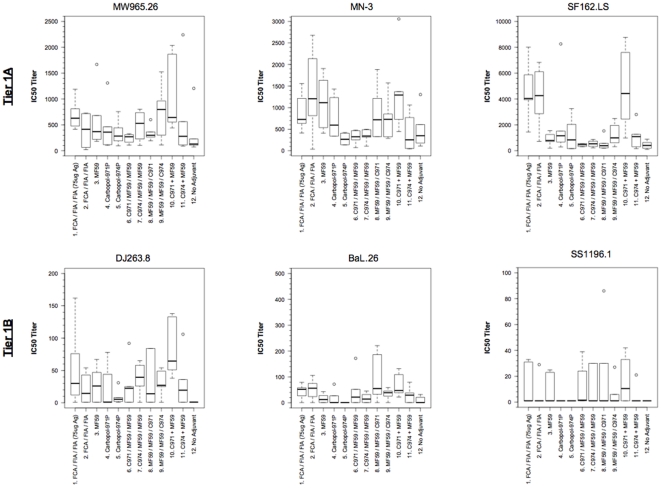
50% Neutralization titer of individual pseudovirus between groups.For single adjuvant, animals vaccinated with FCA/FIA (groups 1 and 2) have the highest titers against the tier 1A viruses, and low titers against tier 1B. Sequential immunization with different prime-boost combination of Carbopol-971P/974P and MF59 (groups 6–9) performed no better than using FCA/FIA or MF59 alone. By contrast, the combination of Carbopol-971P and MF59 (group 10) conferred significantly higher neutralization titers over all others (p<0.05), particularly against the tier 1B viruses DJ263.8 and SS1196.1.